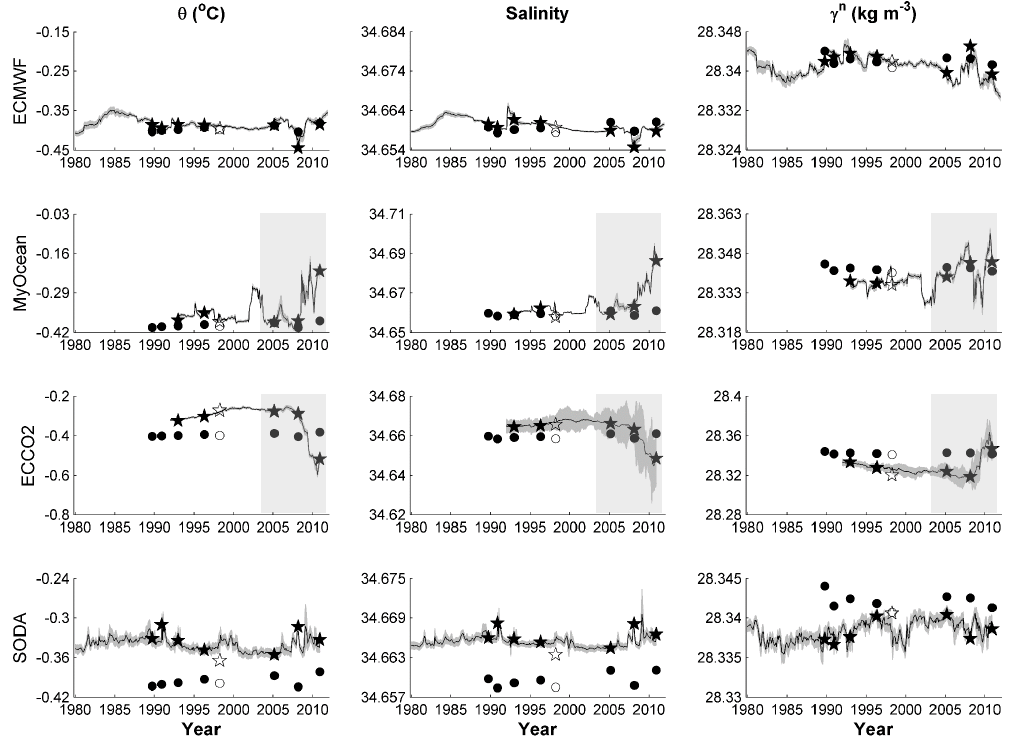
Figure 14. Same as in Fig. 12, but for WSDW. 1151